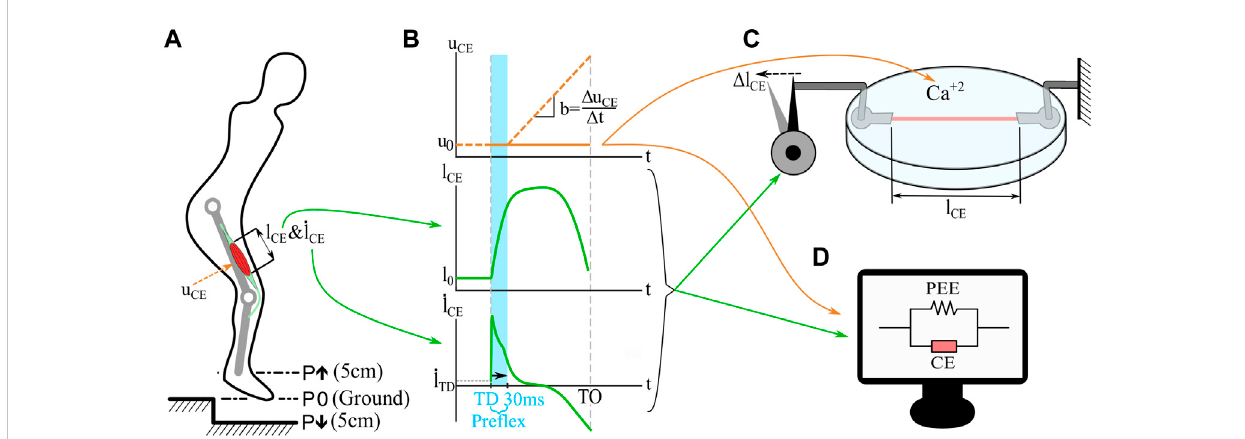
FIGURE 1 Simulations and in vitro experiments applied in this study. A Hill-type model muscle-tendon unit drives a knee extensor unit of the hopper (Geyer et al., 2003; Haeu fl e et al., 2014; Izzi et al., 2023). Single-leg hopping is computer-simulated (A) with three perturbation scenarios: 5 cm step-up (P ↑ ), no perturbation (P0), and 5 cm step-down (P ↓ ). The model outputs are length changes of the contractile element (l CE , (B) ), and contraction velocities ( _ l CE , (B) ).Onehoppingcyclefromtouchdown(TD)totoe-off(TO)isextracted fortheanalysis.Sincethefocusofthisstudyisthemusclebehaviorduring thepre fl exphaseofahoppingcycle(the fi rst30 msofthestancephase),wefocusedontimezoneshownwiththebluearea (B) .Inthistimezonethereis noin fl uenceofre fl exesonthemuscleactivationandweassumenoactivityriseduetofeed-forwardmuscleactivation.Thus,constantstimulationpro fi le (u CE -orange line is shown only for 15% stimulation level, (B) ) is then applied to in vitro muscle fi ber experiments (C) and isolated contractile element (CE) simulations (D) . Constant stimulation in experiments and isolated contractile element simulations were used since the in vitro setup does not allow changing stimulation levels within a stretch-shortening cycle. Since the muscle fi bres used in in vitro experiments (C) are isolated from the tendon, the contractile element (CE) and parallel elastic element (PEE) of the Hill-type muscle model are also isolated from the tendon unit (D)